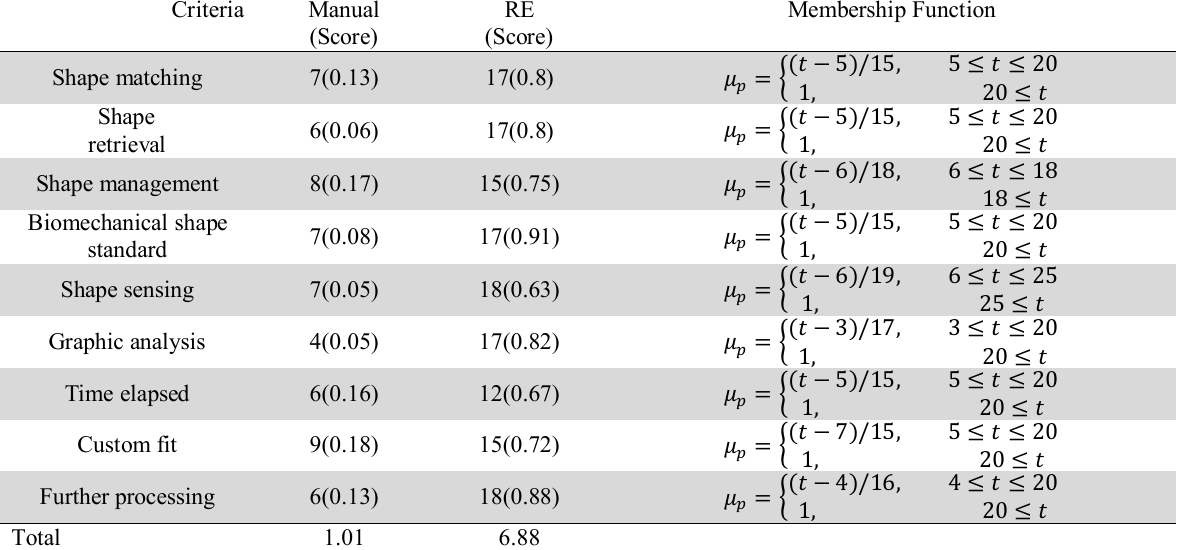
Membership functions and scores for manufacturing process criteria